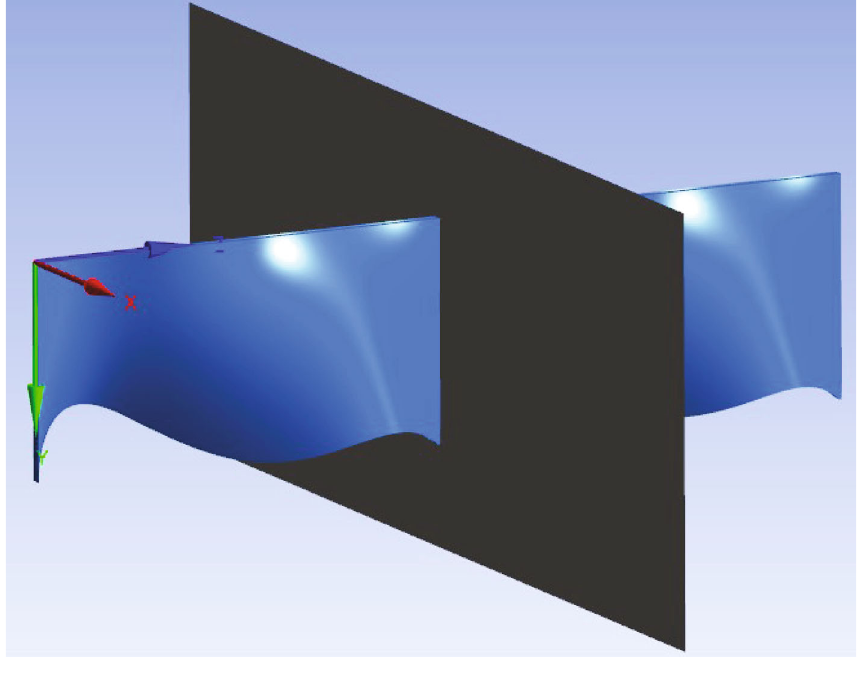
Figure 8: Section position.